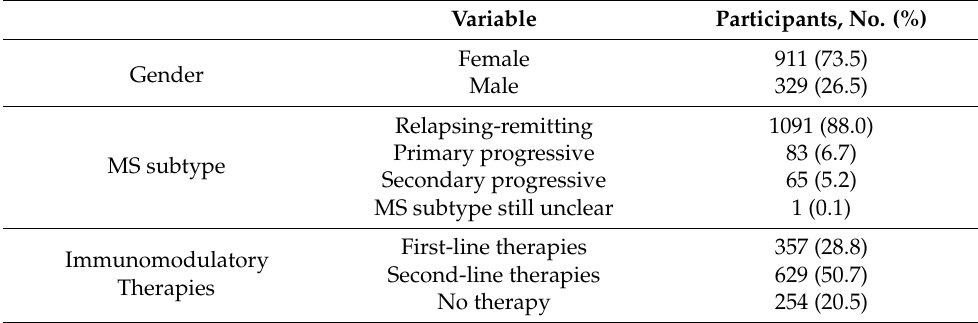
Table 3. Demographic and clinical characteristics of the patients ( N = 1240). First-line therapies subsume the disease-modifying drugs azathioprine, Glatirameracetate, Dimethylfumarat, Interferons and Teriflunomide. Second-line therapies subsume the high-efficacy MS treatments Alemtuzumab, Cladribine, S1P Modulators, Natalizumab, Anti-CD20 treatments.